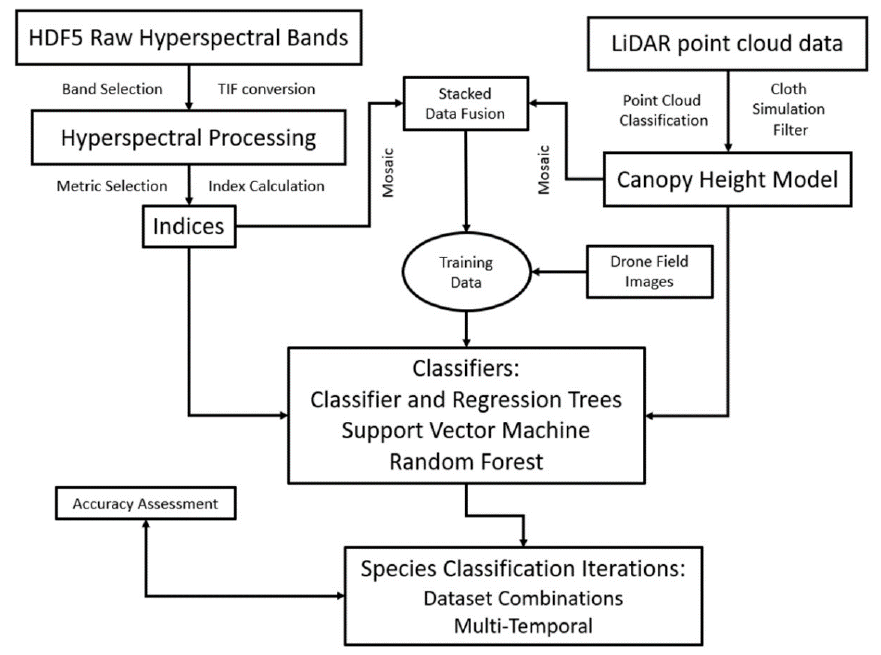
Figure 2. Methodology Flowchart—Hyperspectral and LiDAR processing, data fusion, and classification steps.